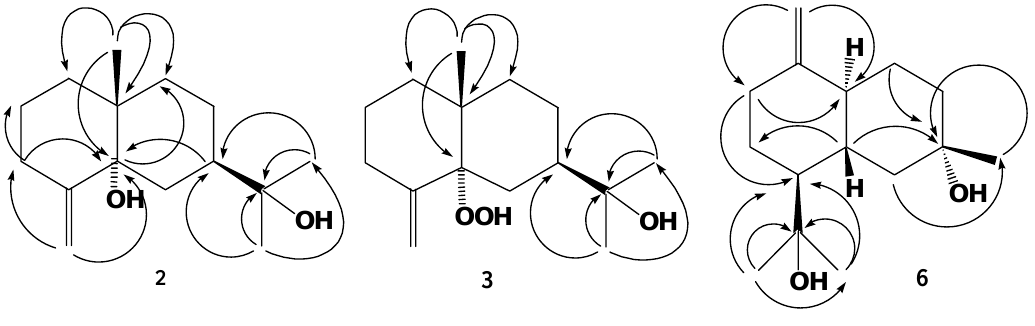
Figure 1. Significant HMBC correlations observed in compounds 2 , 3 and